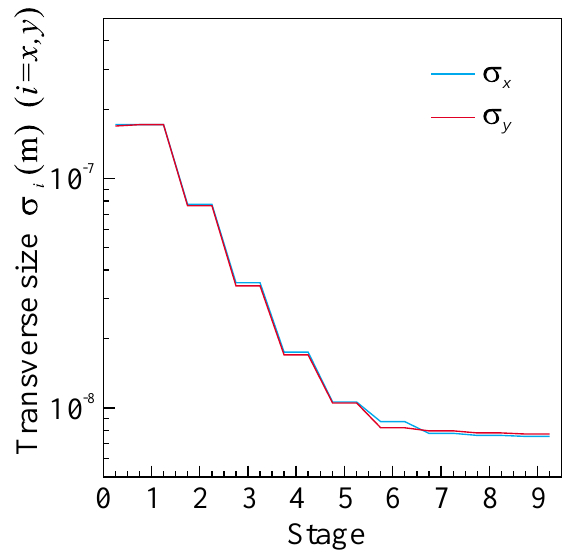
FIG. 4. (Color) The transverse emittances of the electron beams.